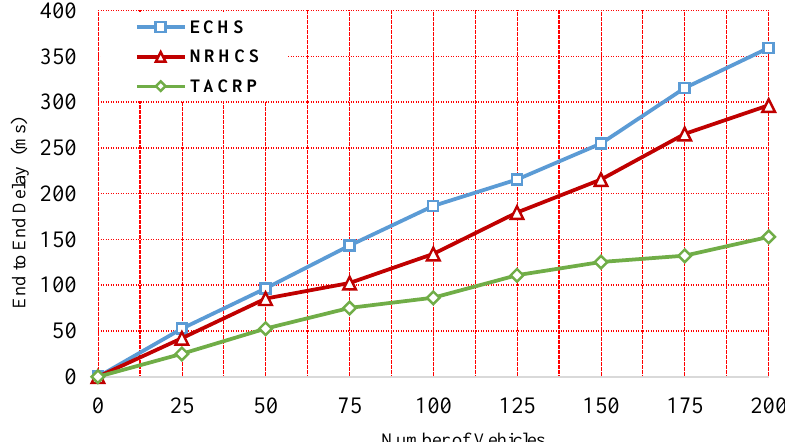
Figure 7. End to End Delay Calculation.